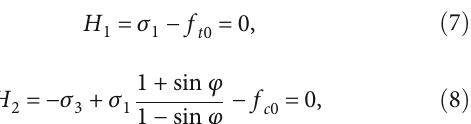
Figure 1: The evolution of density and viscosity of CO pressure at 350K.